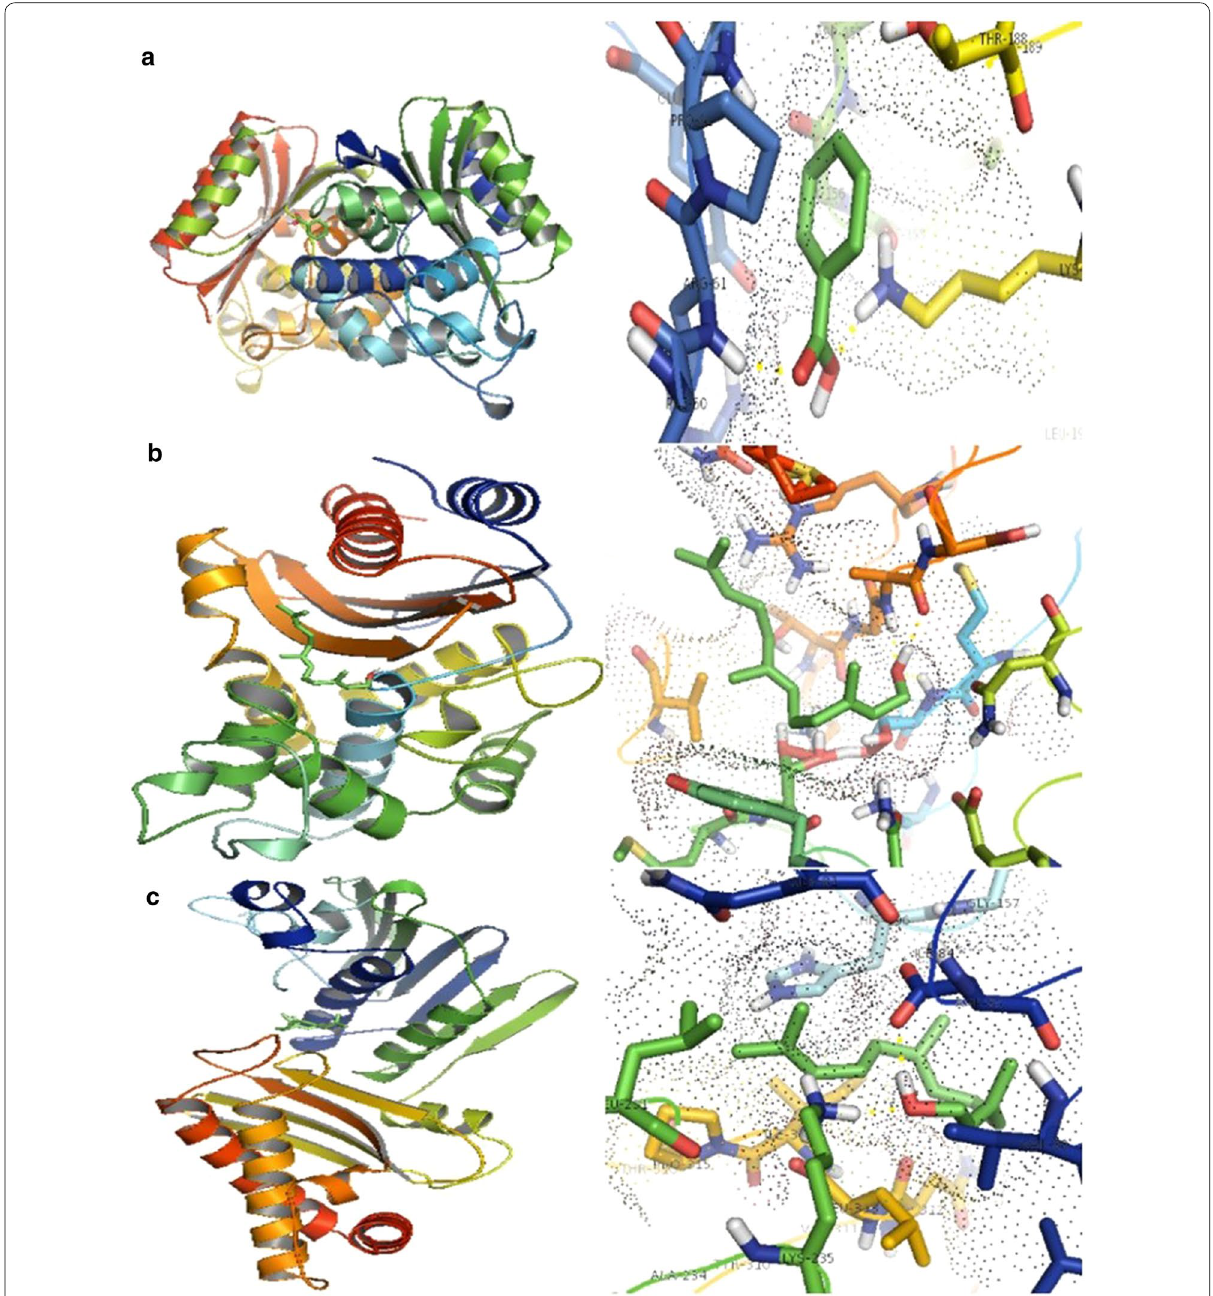
Fig. 4 Putative binding poses of ligands docked with TEM-72, SHV-2 and topoisomerase IV. The yellow dotted line indicates the H -bonding between the ligand and protein. a Molecular interaction of ligand benzoic acid-4-ethoxy-ethyl ester with TEM-72. b Molecular interaction of ligand farnesol acetate with SHV-2. c Molecular interaction of ligand farnesol acetate with Topoisomerase